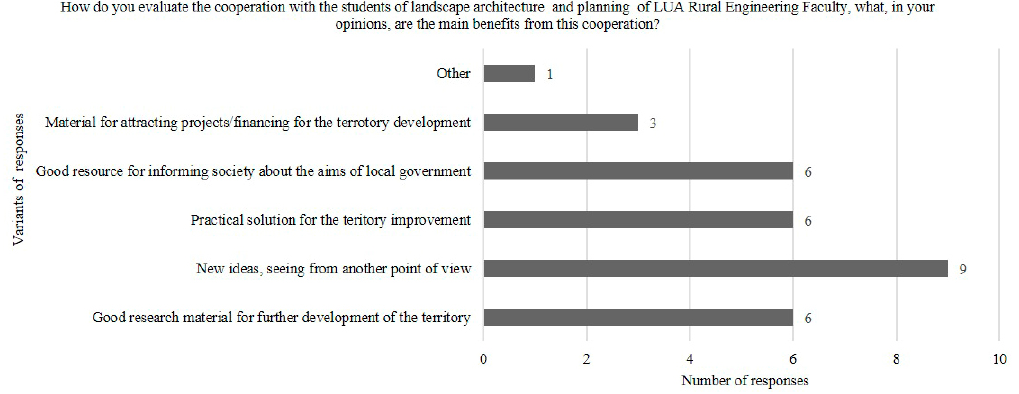
Fig. 3. Survey results about first question